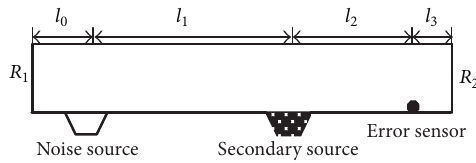
Figure 1: Schematic diagram for a duct-like